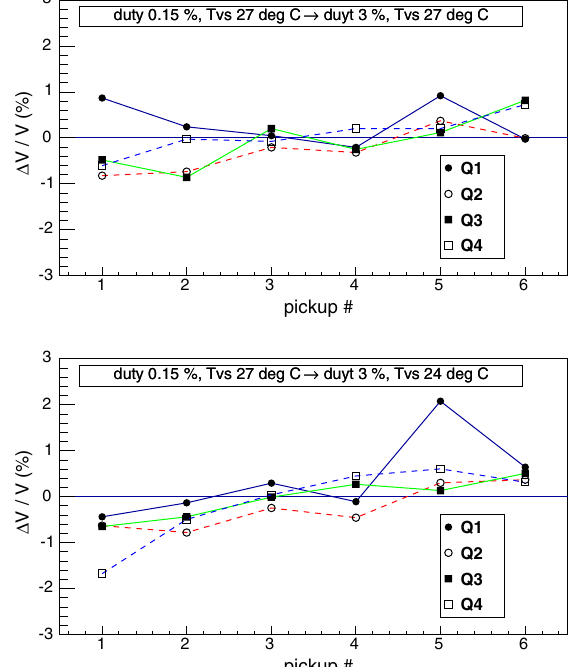
FIG. 11. Field distributions measured by pickup monitors. The upper figure represents the voltage difference (cid:1) V=V between a duty factor of 0.15% and 3% keeping T vs ¼ 27 (cid:1) C . The lower figure is (cid:1) V=V from T vs ¼ 27 (cid:1) C and duty ¼ 0 : 15% to T vs ¼ 24 (cid:1) C and duty ¼ 3%